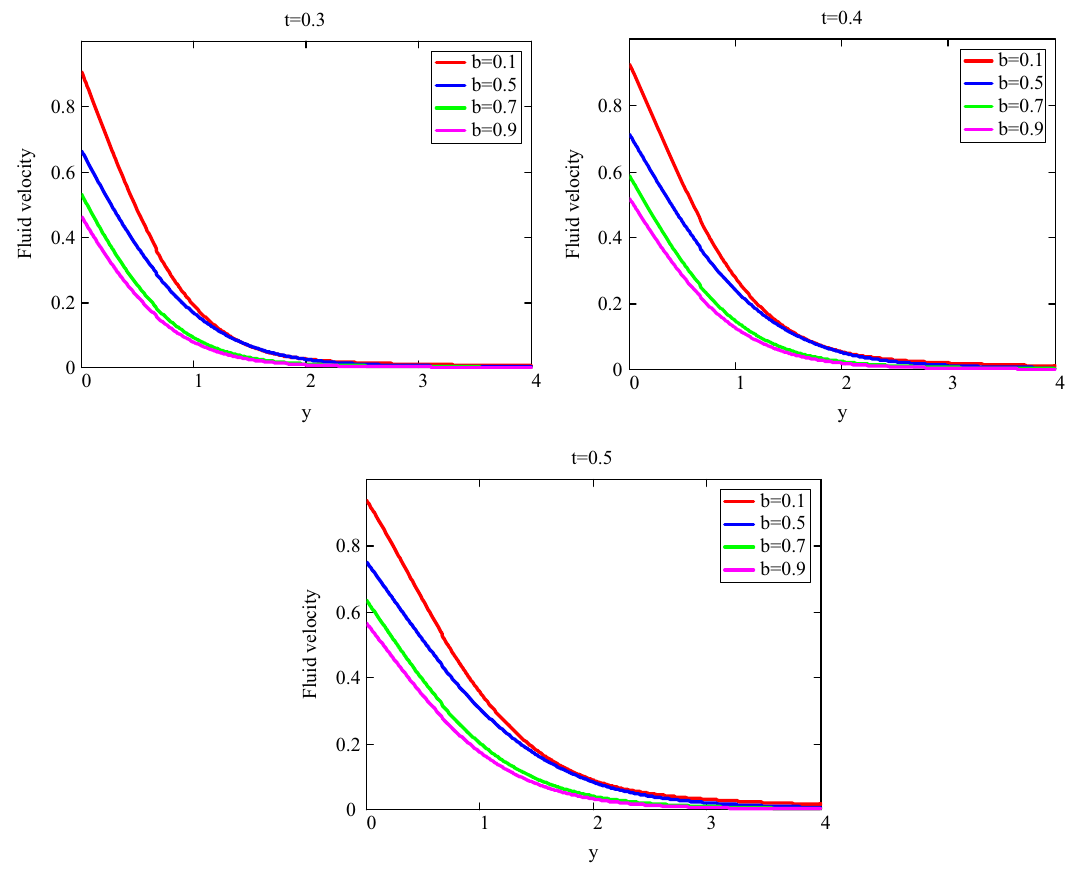
Figure 5: The velocity pro fi le for the variation of the slip parameter at di ff erent times.